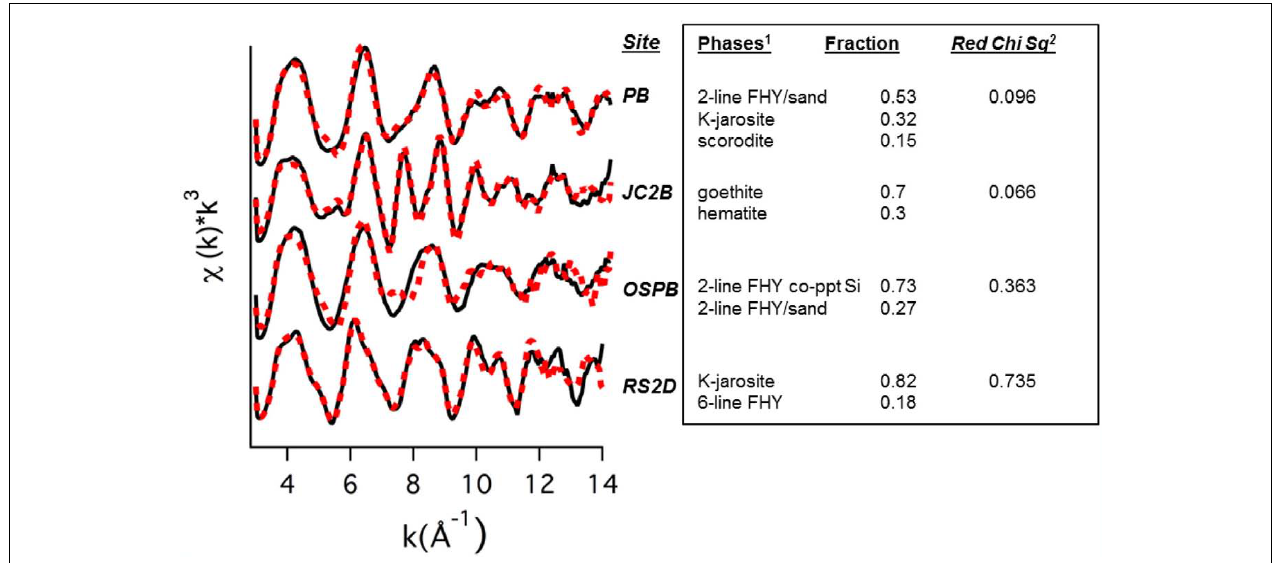
FIGURE 5 | Least squares fits (dotted lines) to experimental k3 weighted Fe-EXAFS spectra (solid lines) obtained for solids from hot springs representing (bio)geochemical end-members. Predicted fractions of major solid phases (Fe standards 1) included in the fits are shown along with the reduced Chi square